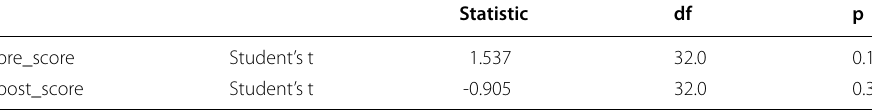
Table 5 Independent samples T‑test (gender)